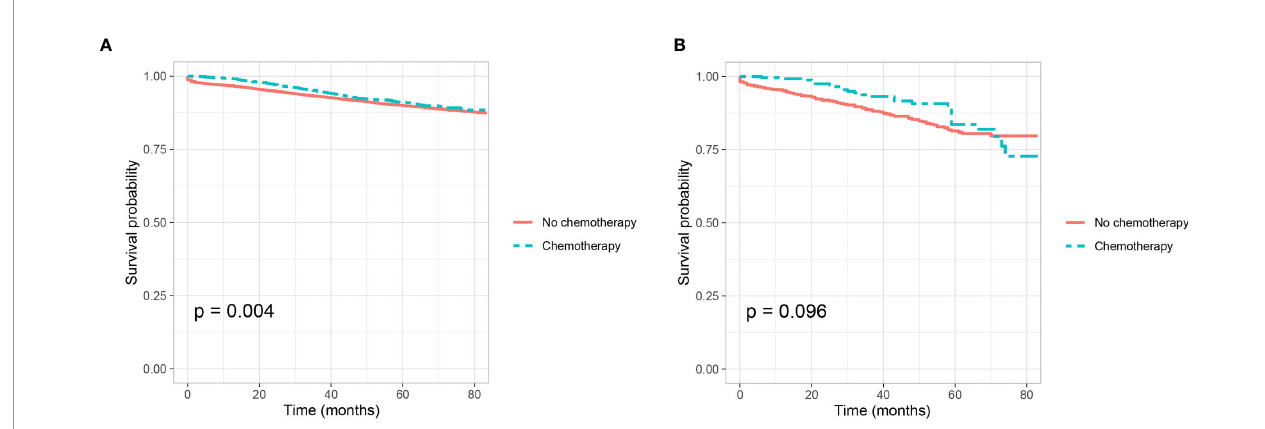
FIGURE 2 | Kaplan – Meier curves for cancer-speci fi c survival according to the receipt of chemotherapy (no chemotherapy VS. chemotherapy) in stage IIA colon cancer (A) with the presence of perineural invasion (P = 0.004) and (B) without the presence of perineural invasion (P